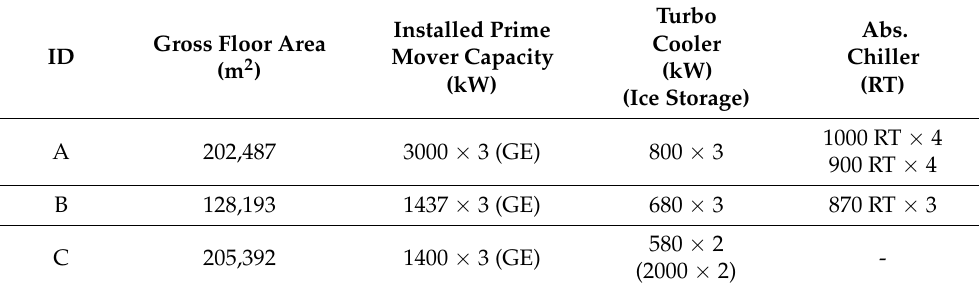
Table 1. Basic building and facility information for the terminal